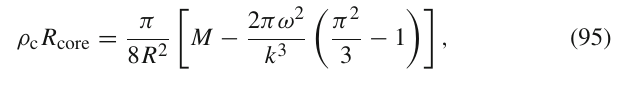
Fig. 3 Variation of the mean value of the logarithmic density slope (cid:8) α (cid:9) for a rotating Bose–Einstein condensate dark matter halo as a BEC function of (cid:14) , for different values of the core radius R core : R cor e = 0 . 30 R (solid curve), R core = 0 . 35 R (dotted curve), R core = 0 . 40 R (short dashed curve), R core = 0 . 45 R (dashed curve), R core = 0 . 50 R (long dashed curve), and R core = 0 . 55 R (ultra-long dashed curve),